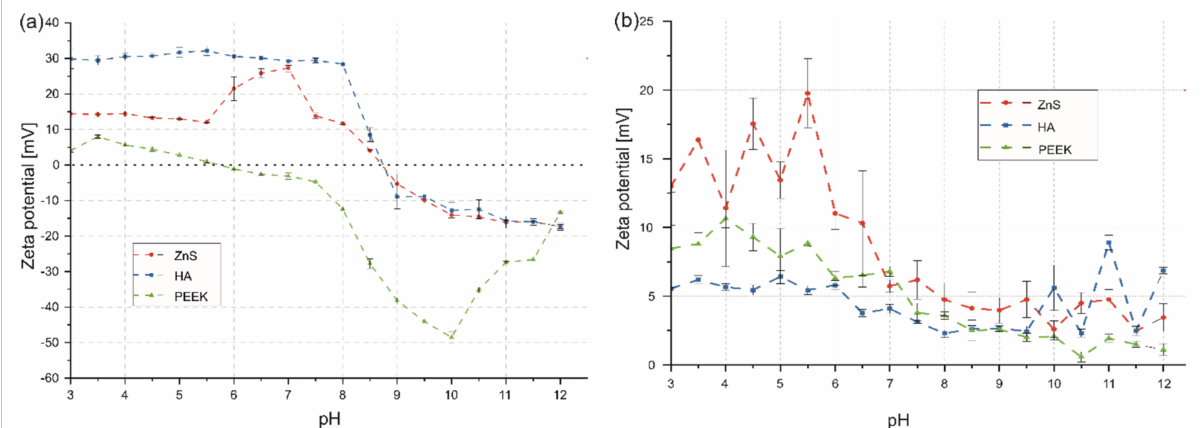
Figure 5. ZDP of n-HA, ZnS and PEEK particles in pure EtOH ( a ) and EtOH with the addition of 5 vol % CHp ( b ) in accordance with the suspension